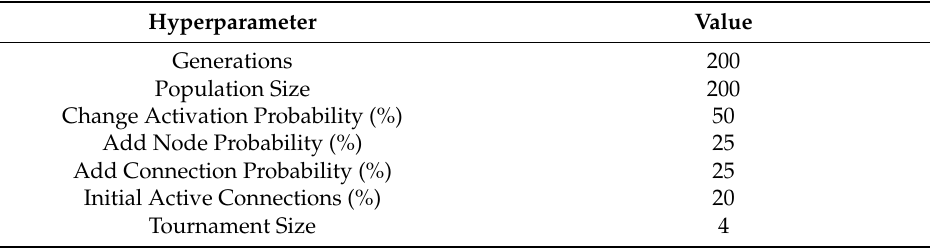
Table 2. The hyperparameter selection for the weight agnostic neural